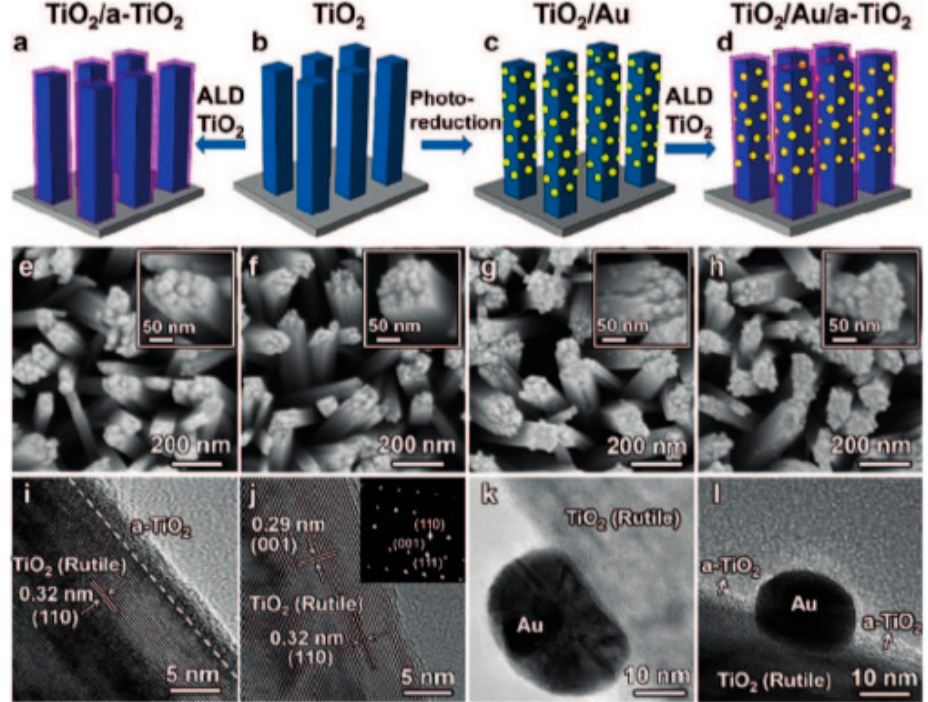
Figure 9. ( a – d ) Illustration of the experimental procedures for preparation of bare TiO 2 , TiO 2 /Au, TiO 2 /a-TiO 2 , and TiO 2 /Au/a-TiO 2 photo-electrodes. ( e – h ) Scanning electron microscopy (SEM) and ( i – l ) HRTEM images of photoelectrodes. Key: TiO 2 /a-TiO 2 ( a , e , i ), bare TiO 2 ( b , f , j ) (inset:selected area electron diffraction (SAED) pattern of the bare TiO 2 NR), TiO 2 /Au ( c , g , k ), TiO 2 /Au/a-TiO 2 ( d , h , l ). (Reproduced with permission from Wiley [56]).